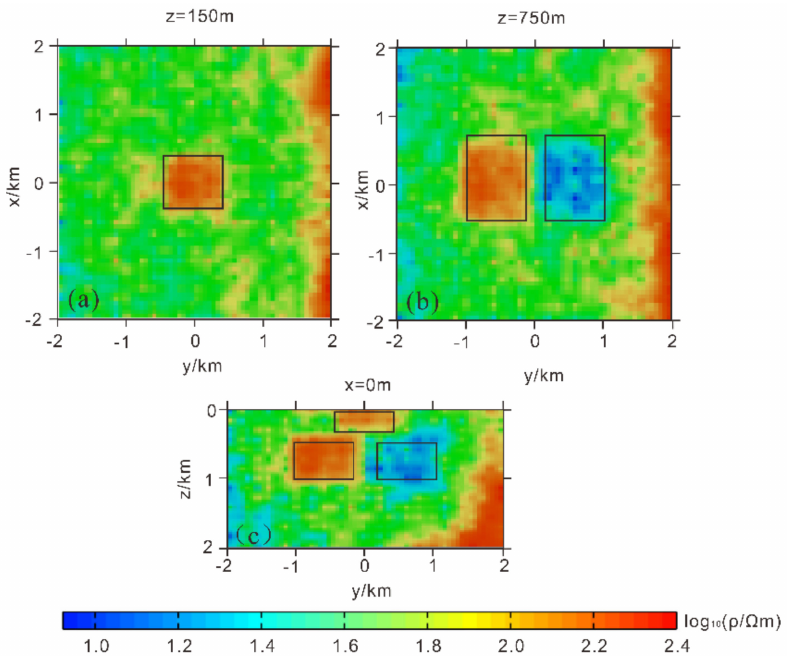
Figure 9. Inversion result yielded by the PSO algorithm. ( a ) Horizontal sectional view at z = 150 m.